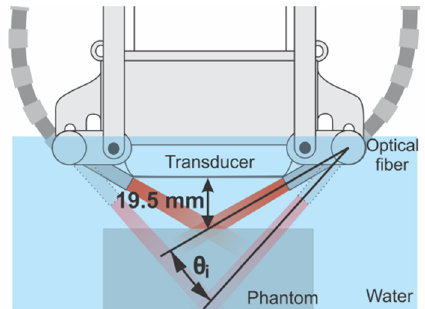
Figure 3. Depiction of the experimental setup used to acquire the multiangle long-axis lateral illumination PA images. The distance of 19.5 mm between the transducer and the phantom surface forces the focal illumination region to be at the phantom surface for θ i = 0 ◦